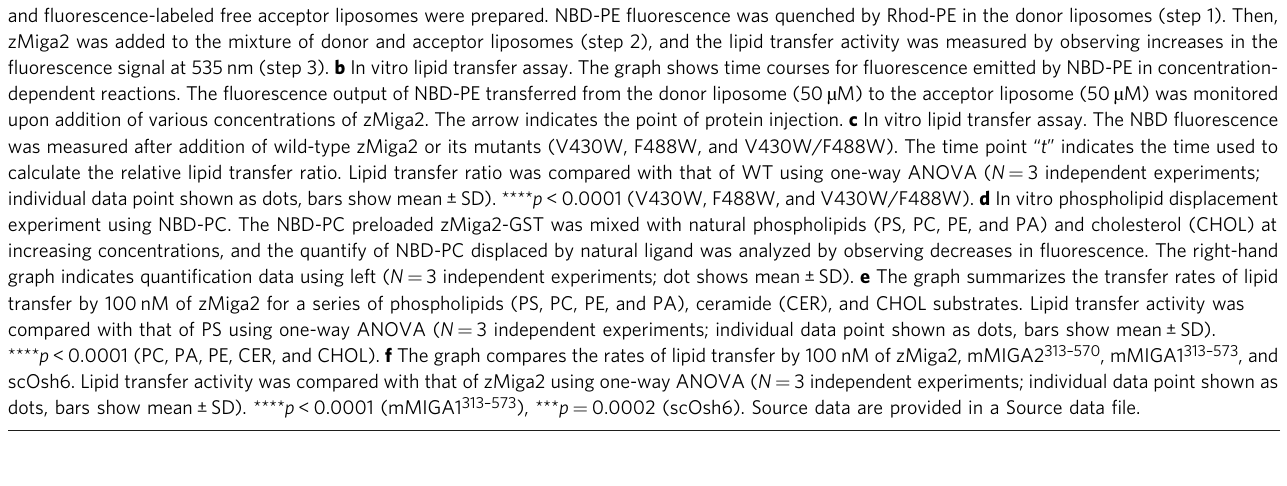
Fig. 4 MIGA2 prefers to transfer PS. a Schematic diagram showing the lipid transfer assay. Brie fl y, donor liposomes containing both NBD-PE and Rhod-PE and fl uorescence-labeled free acceptor liposomes were prepared. NBD-PE fl uorescence was quenched by Rhod-PE in the donor liposomes (step 1). Then, zMiga2 was added to the mixture of donor and acceptor liposomes (step 2), and the lipid transfer activity was measured by observing increases in the fl uorescence signal at 535 nm (step 3). b In vitro lipid transfer assay. The graph shows time courses for fl uorescence emitted by NBD-PE in concentration- dependent reactions. The fl uorescence output of NBD-PE transferred from the donor liposome (50 µ M) to the acceptor liposome (50 µ M) was monitored upon addition of various concentrations of zMiga2. The arrow indicates the point of protein injection. c In vitro lipid transfer assay. The NBD fl uorescence was measured after addition of wild-type zMiga2 or its mutants (V430W, F488W, and V430W/F488W). The time point “ t ” indicates the time used to calculate the relative lipid transfer ratio. Lipid transfer ratio was compared with that of WT using one-way ANOVA ( N = 3 independent experiments; individual data point shown as dots, bars show mean ± SD). **** p < 0.0001 (V430W, F488W, and V430W/F488W). d In vitro phospholipid displacement experiment using NBD-PC. The NBD-PC preloaded zMiga2-GST was mixed with natural phospholipids (PS, PC, PE, and PA) and cholesterol (CHOL) at increasing concentrations, and the quantify of NBD-PC displaced by natural ligand was analyzed by observing decreases in fl uorescence. The right-hand graph indicates quanti fi cation data using left ( N = 3 independent experiments; dot shows mean ± SD). e The graph summarizes the transfer rates of lipid transfer by 100 nM of zMiga2 for a series of phospholipids (PS, PC, PE, and PA), ceramide (CER), and CHOL substrates. Lipid transfer activity